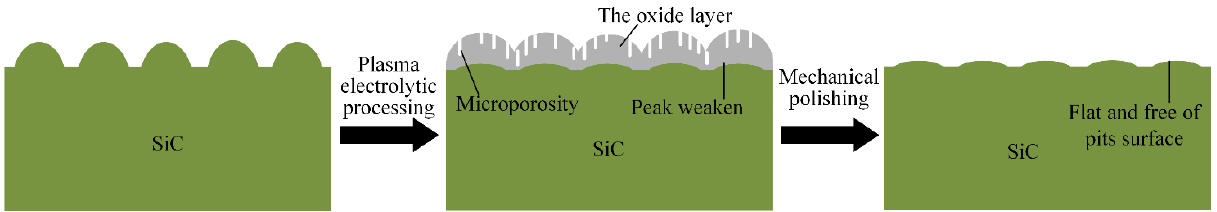
Figure 1. Schematic of plasma electrolytic processing and mechanical polishing (PEP-MP) step.